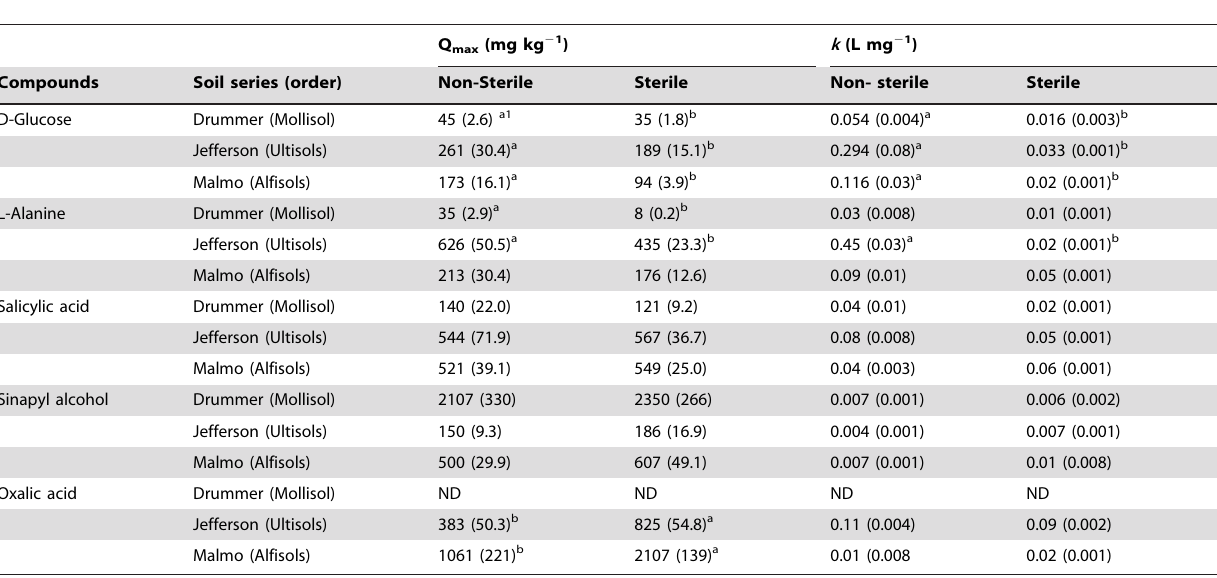
Table 4. Comparison of Langmuir sorption parameters of sterile soils with corresponding non-sterile